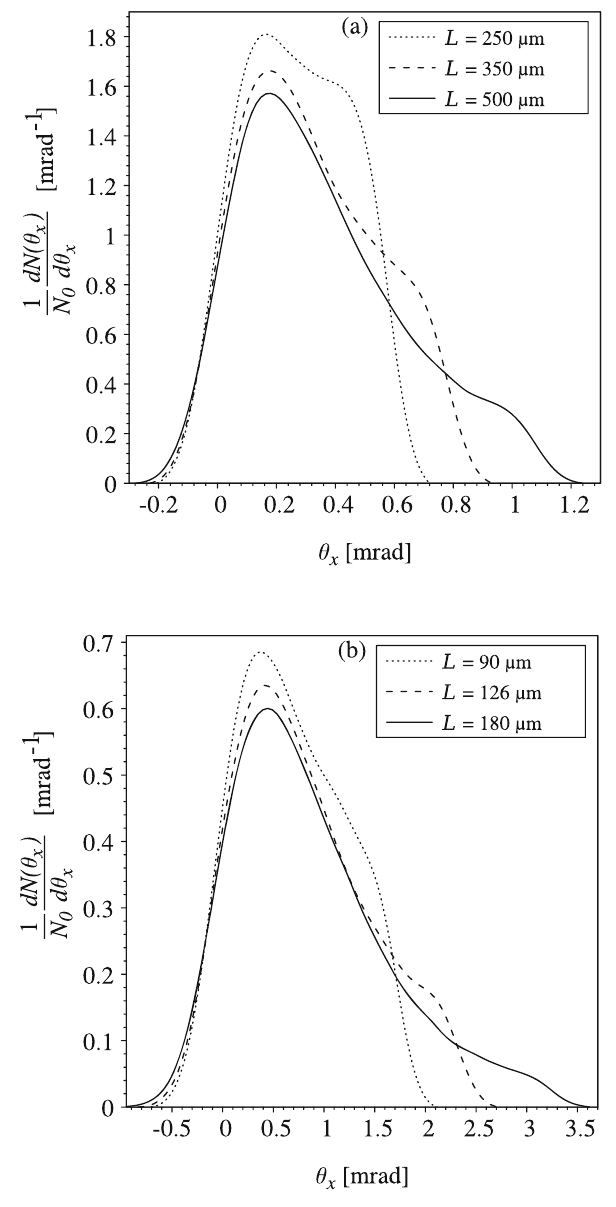
Fig. 9 The density of the angular distributions of antiprotons after passing through a bent crystal in optimal conditions for deflection (axial alignment of the crystal with respect to the direction of beam incidence, R = R opt ). a E = 10 GeV, b E = 1 GeV. N 0 is the total number of particles in the beam, N (θ x ) is the number of particles whose angle between between the particle momentum and the ( 1 ¯ 10 ) plane exceeds θ